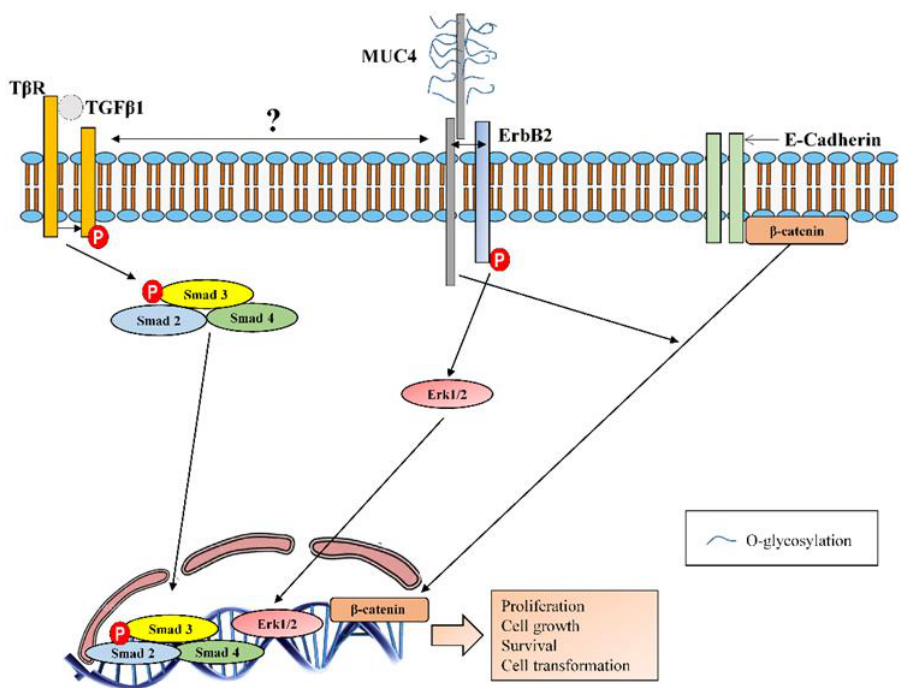
Figure 10. MUC4 molecular interactions. MUC4, via one of the EGF-like domains, serves as an intramembrane ligand for the receptor tyrosine kinase ErbB2. Binding of MUC4 to ErbB2 induces its phosphorylation and enhanced activation of extracellular signal-regulated kinases (Erks) 1 and 2, promoting proliferation, growth, survival and differentiation. MUC4 collaborates with transforming growth factor β1 (TGFβ1) to induce epithelial to mesenchymal transition (EMT) and fibroblast to mesenchymal transition (FMT) in IPF disease, although it is still unknown the exact mechanism of collaboration between MUC4 and TGFβ1 receptor (TβR). MUC4 also induces the nuclear translocation of β -catenin promoting growth, metastasis and angiogenesis.